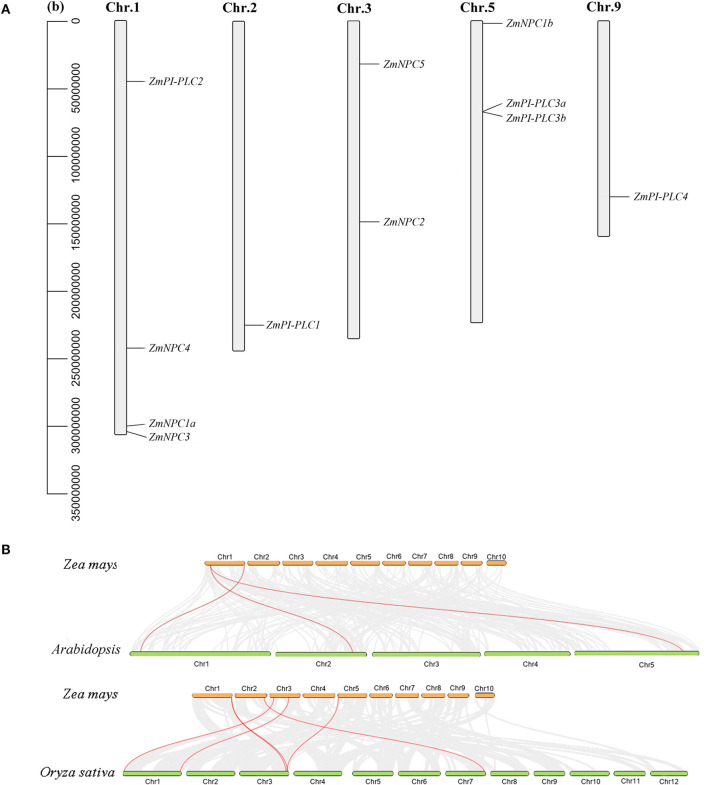
The chromosomal distribution of ZmPLC genes (A) and synteny analysis between ZmPLCs and PLCs from Arabidopsis or rice (B). The number of the chromosome is shown on each chromosome. Gray lines in the background indicate the collinear blocks within maize and other plant genomes, while the red lines highlight the syntenic PLC gene pairs.